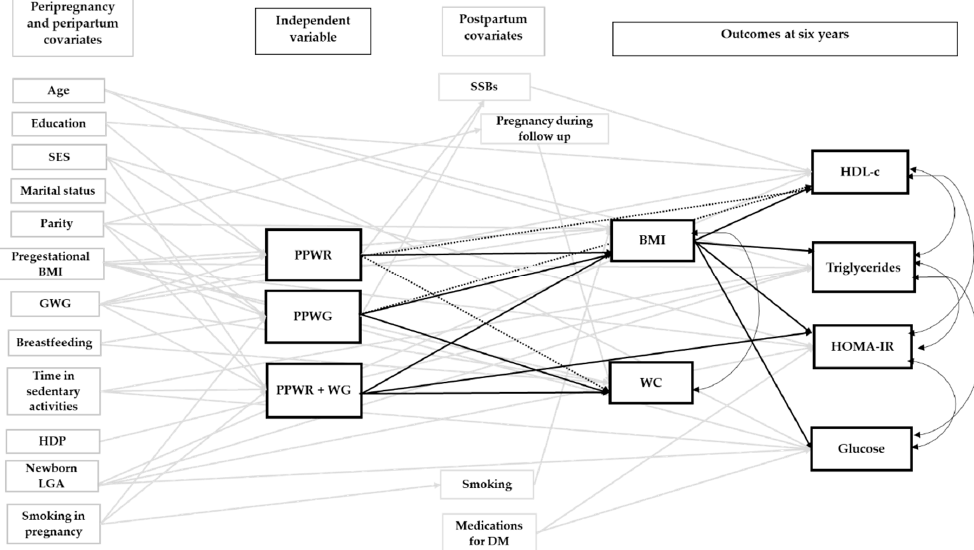
Figure 1. Final path model of the association between patterns of weight change one year after delivery and Outcome Group 1 at six years postpartum. The figure displays direct associations between patterns of postpartum weight change and Outcome Group 1, and indirect associations mediated through BMI. The reference group was women who returned to their pregestational weight by one year postpartum. Arrows represent pathways among variables. The black arrows represent paths relevant to our study objectives. A continuous black arrow indicates a statistically significant association ( p < 0.05); a doted black arrow represents a tendency of association (0.05 ≤ p < 0.10). BMI, body mass index; DM, diabetes mellitus; GWG, gestational weight gain; HDL-c, high-density